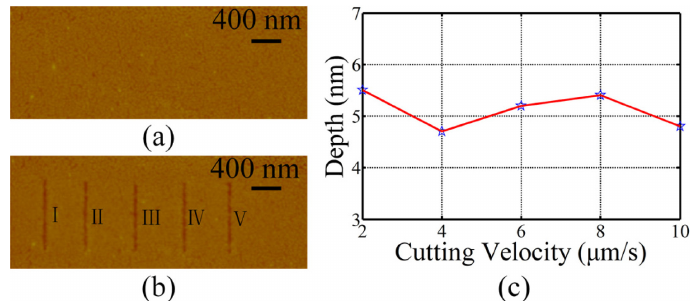
Figure 4. ( a ) Height image of the graphene before cutting; ( b ) height image of the graphene after cutting at cutting velocities of 2 μm/s (I) , 4 μm/s (II) , 6 μm/s (III) , 8 μm/s (IV), and 10 μm/s (V) with normal force of 15.88 μN ; and ( c ) the cut depth versus the cutting velocity.